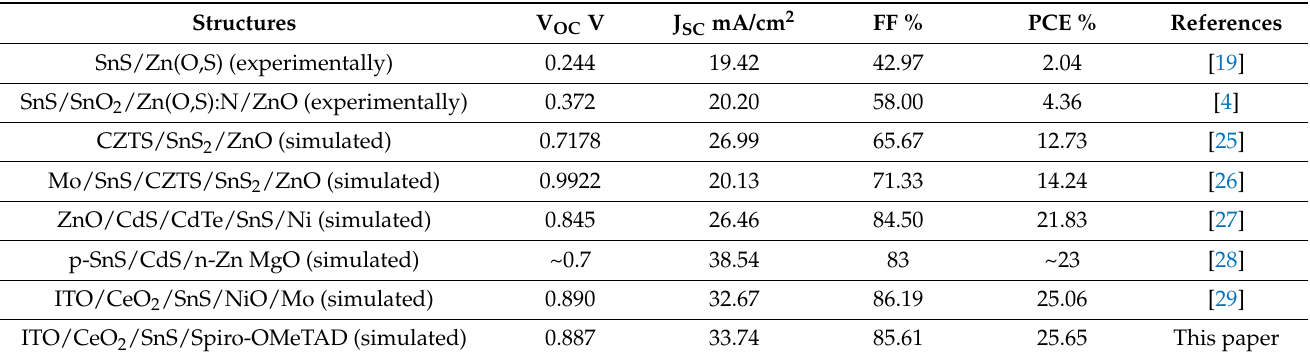
Table 3. Comparison of physical parameters of various simulated and experimentally studied device